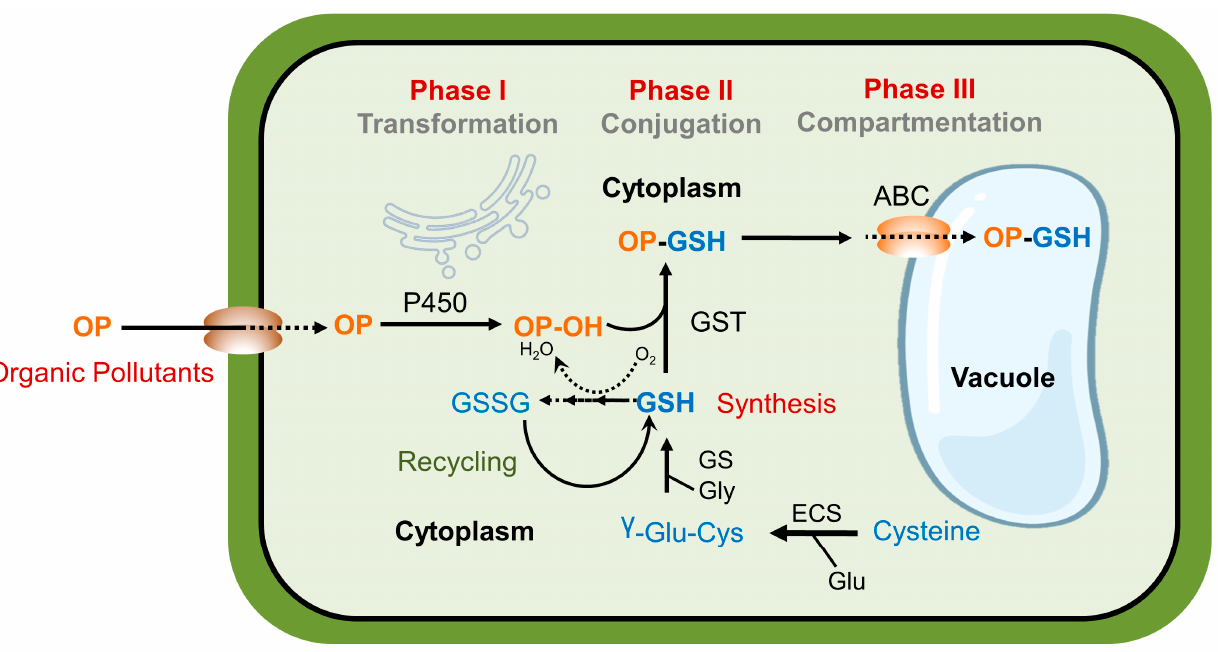
Figure 2. Mechanisms of organic pollutant detoxification in plants.